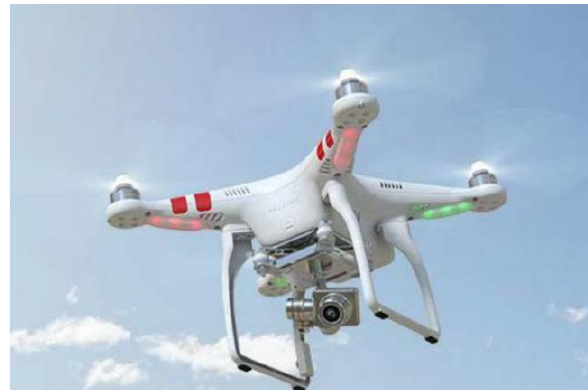
Figure 2. The DJI Phantom 2 Vision+ quadcopter sUAS.